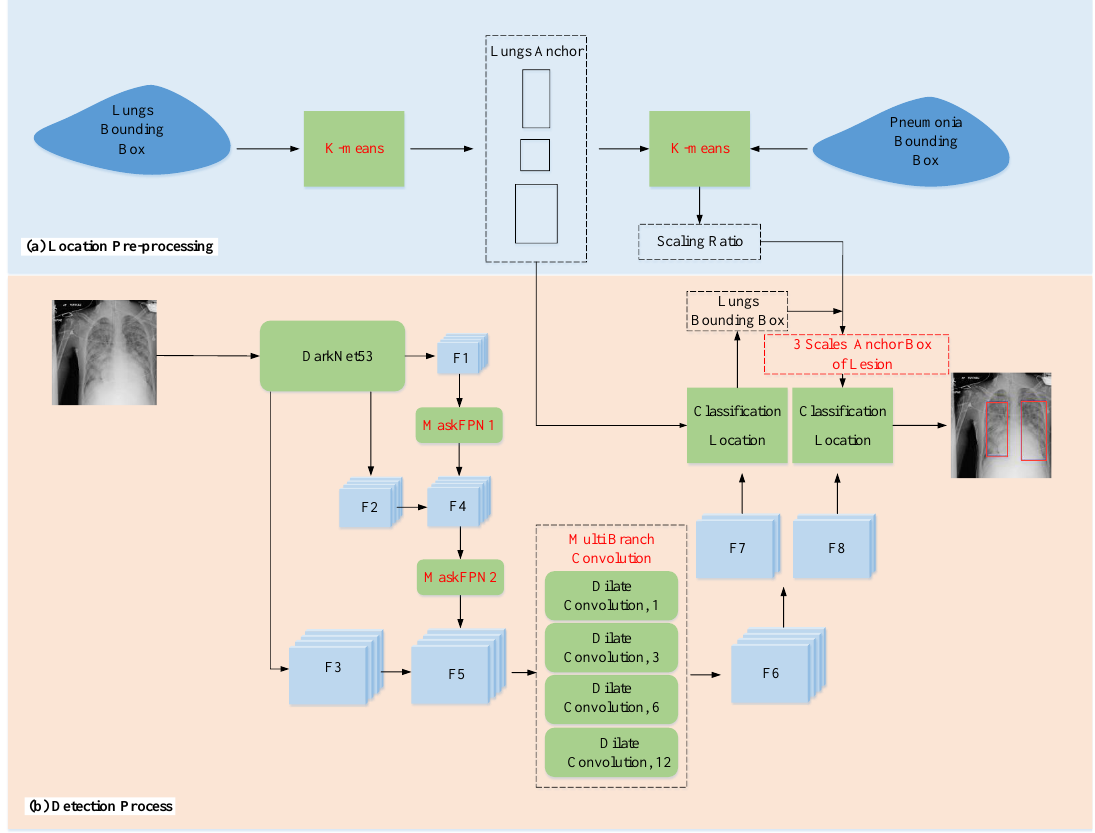
Figure 3. Structure of Pneumonia Yolo (PYolo). The highlighted red text indicates improvements based on Yolov3 in this study. In the multi-branch convolution module, 1, 3, 6, and 12 represent different dilation rates: ( a ) location pre-processing; ( b ) detection process.